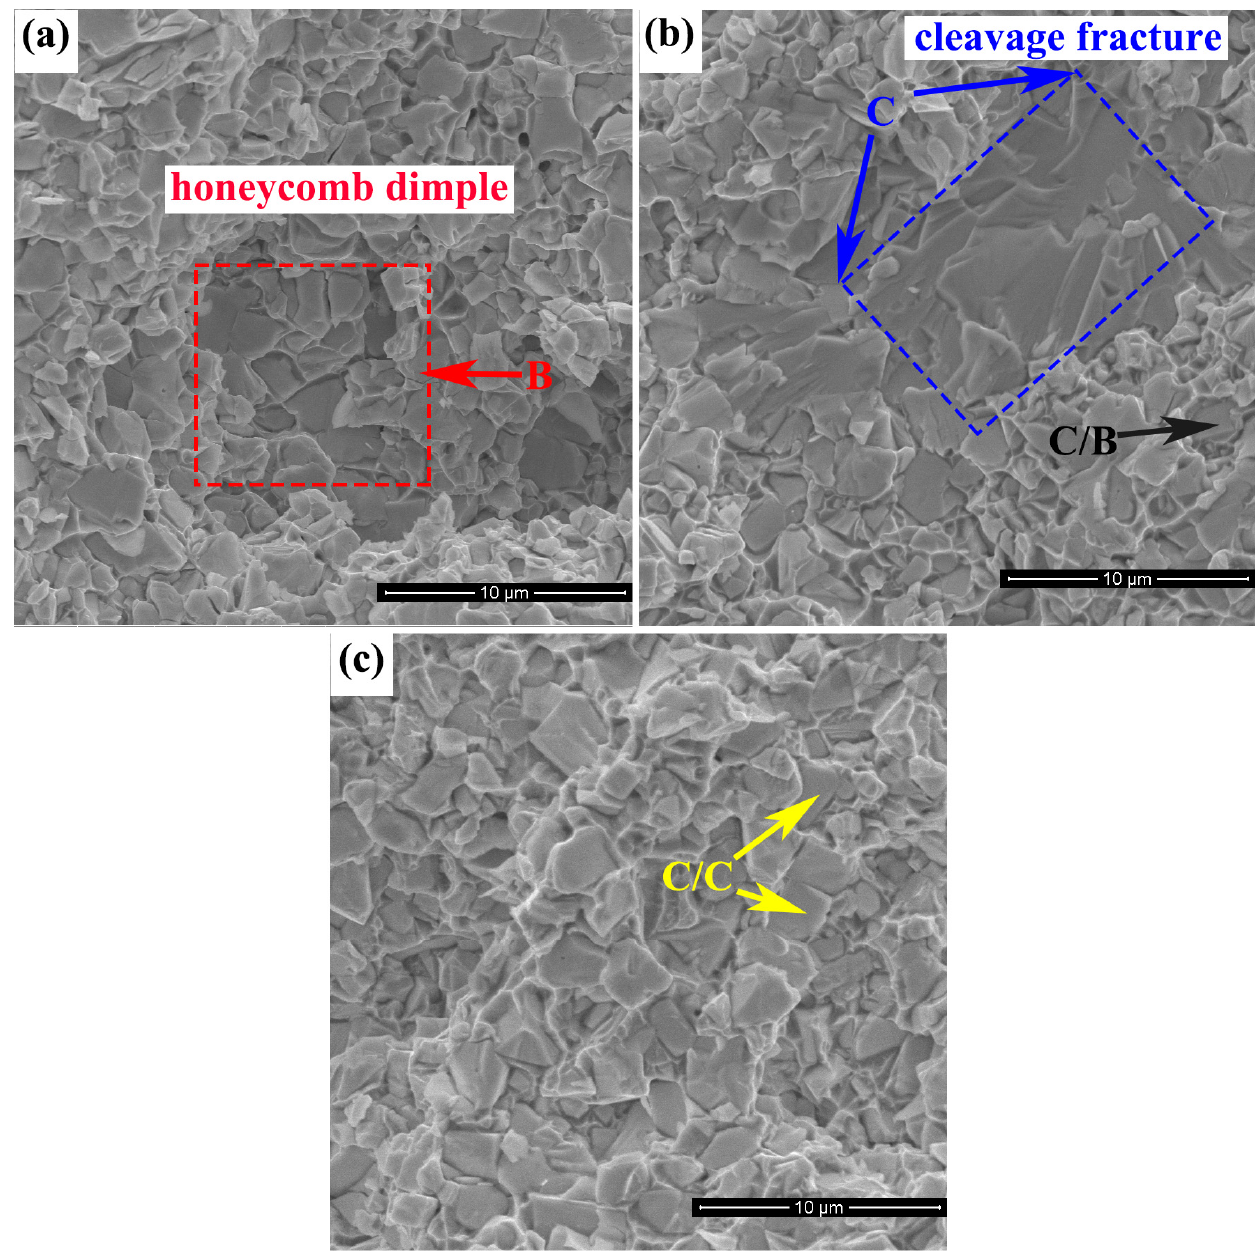
Figure 8. Fracture morphology of the cemented carbides: ( a ) Alloy 5, ( b ) Alloy E and ( c ) WC ‐ Co.